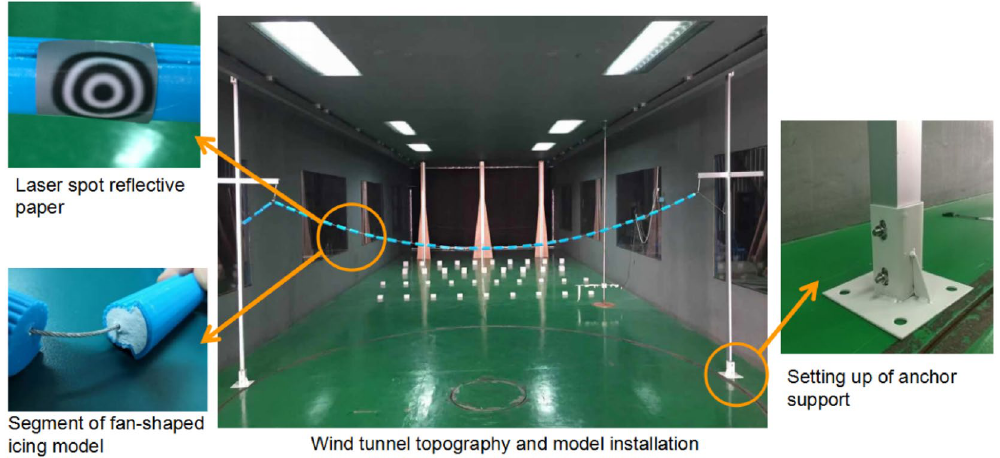
Figure 3. Photos of wind tunnel test with details of model configurations and